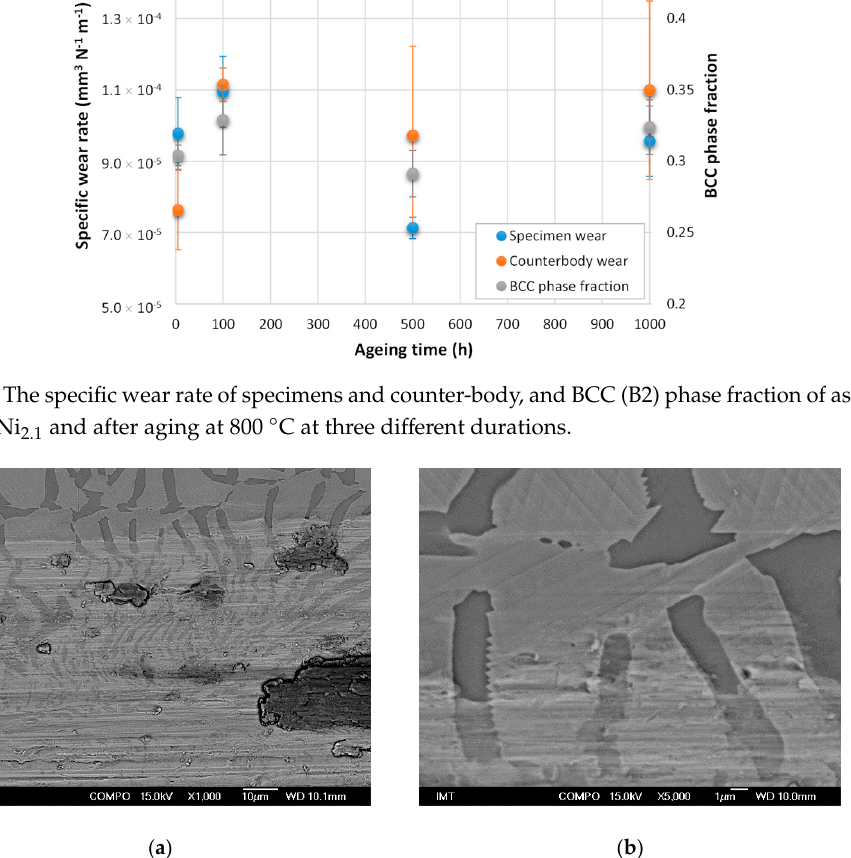
Figure 11. SEM-BSE images of wear tracks of AlCoCrFeNi 2.1 CCA in as-the cast state: ( a ) Wear track edge with patches of re-deposited material; ( b ) Slip lines in the vicinity of wear track.